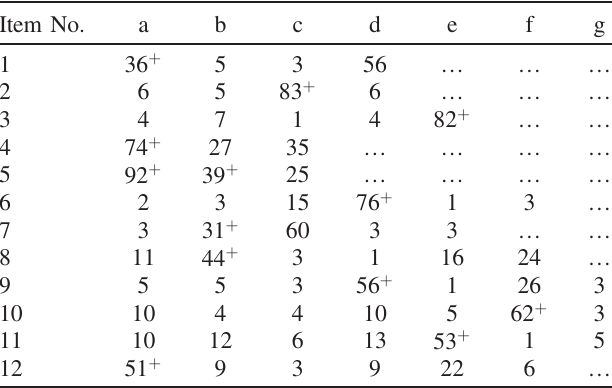
answer alternatives marked with a + are the correct answers. Items 4 and 5 consist of three true or false questions, respectively. In this table, these two items have been coded in the way that the numbers for each answer alternative correspond to the relative frequency of participants who thought that the field-line repre- sentation in the true or false questions a, b), and c) corresponds to the vector-field plot in the item